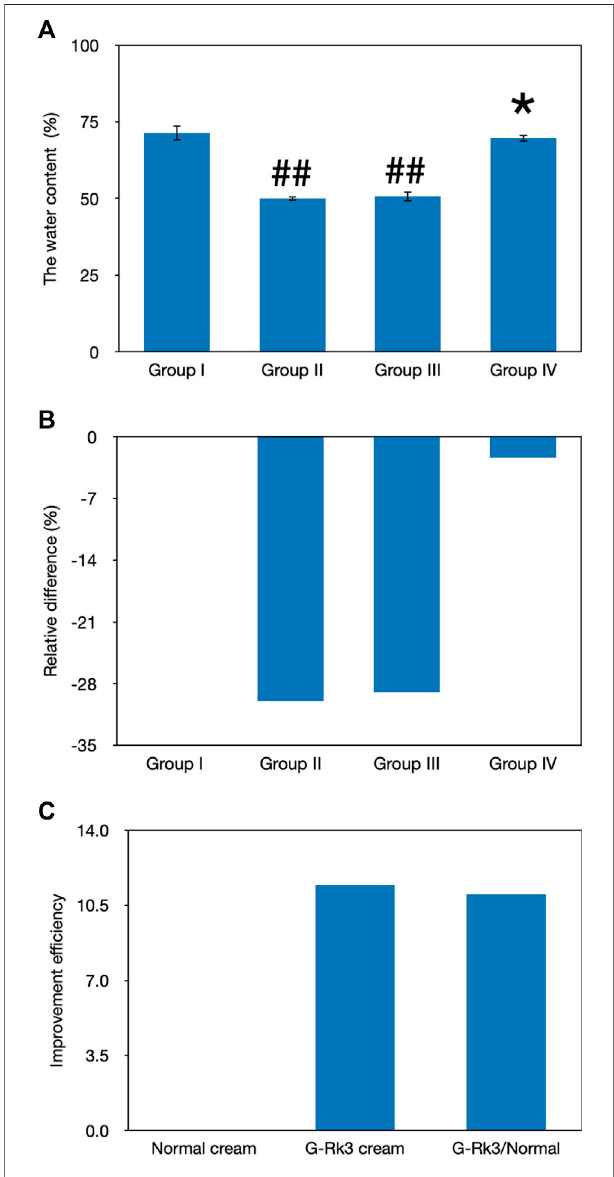
FIGURE 5 | Evaluation of the water content. The absolute value of the water content (A) . ##Very signi fi cantly different from group I, p < 0.01. *Not different from group I, p > 0.05. Relative differences in the four groups (B) . Improvement ef fi ciencies of normal and G-Rk3 creams (C) .